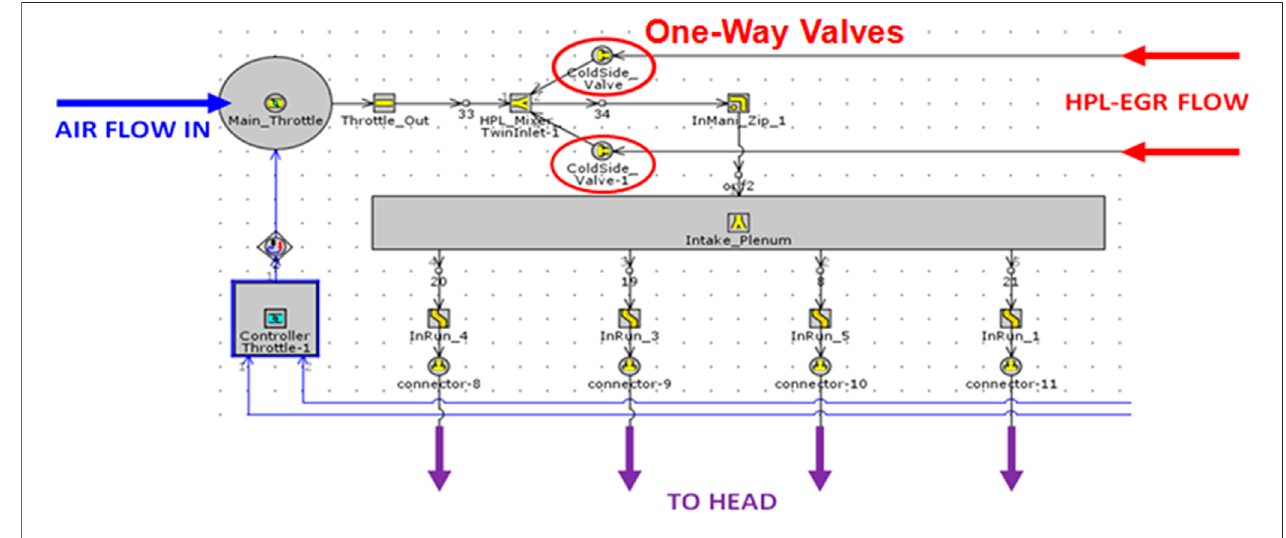
FIGURE 9 | One-way Valve modeled in GT-Power.